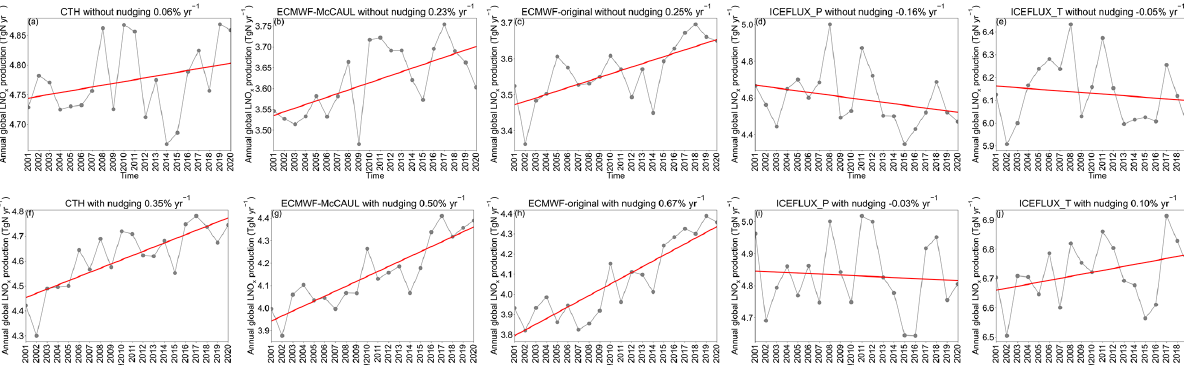
Figure 14. Trends of annual global LNO x emissions calculated from simulation results (2001–2020) from different lightning schemes. Red lines are fitting curves. Panels (a) – (e) present results without nudging; panels (f) – (j) present results with nudging. The number in the title of each figure represents the trend corresponding to that figure in the unit of percent per year (%yr − 1 ).